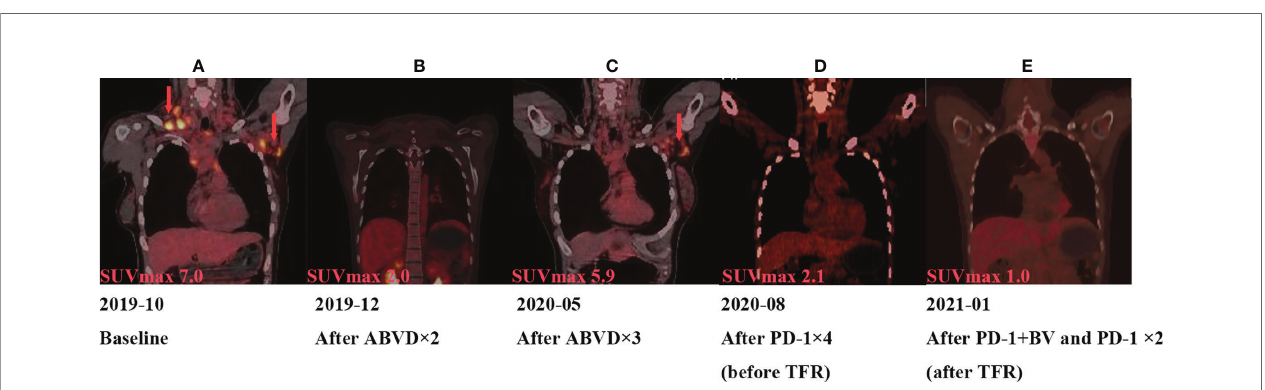
FIGURE 2 | Tumor assessment during treatment by PET. (A) In October 2019, the size of the left axillary lymph node was 3.1 × 2.2 cm, and maximum standard uptake value (SUVmax) from 18F-FDG is 7.0. (B) In December 2019, the size of the left axillary lymph node was 1.51 × 0.84 cm, SUVmax is 2.0. (C) In May 2020, the left axillary lymph node was1.69 × 1.69 cm, and SUVmax is 5.9. (D) In August 2020, the left axillary lymph node was 1.5 cm, and SUVmax is 2.1. (E) In January 2021, PET/CT showed the SUVmax is 2.1.